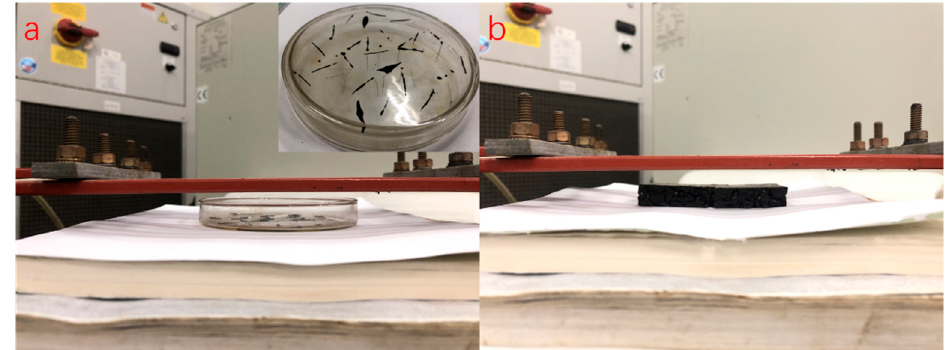
Figure 5. Induction heating test of Dramix asphalt-fibers ( a ) and asphalt concrete ( b ).